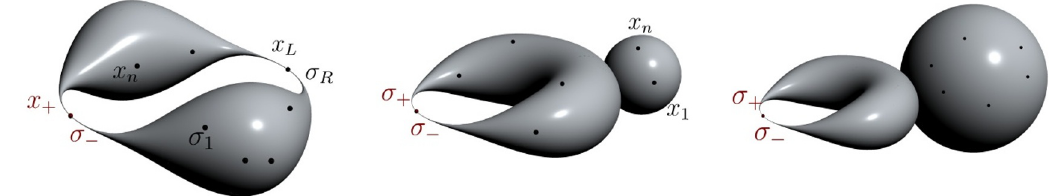
Figure 10 . The singular worldsheet con(cid:12)gurations corresponding to the unphysical poles. The geometry on the left, with + and n on one component and (cid:0) and 1 gives unphysical loop propagators, the middle one is the problematic 1- n massive corner, and the tadpole-like geometry on the right gives an unphysical discriminant